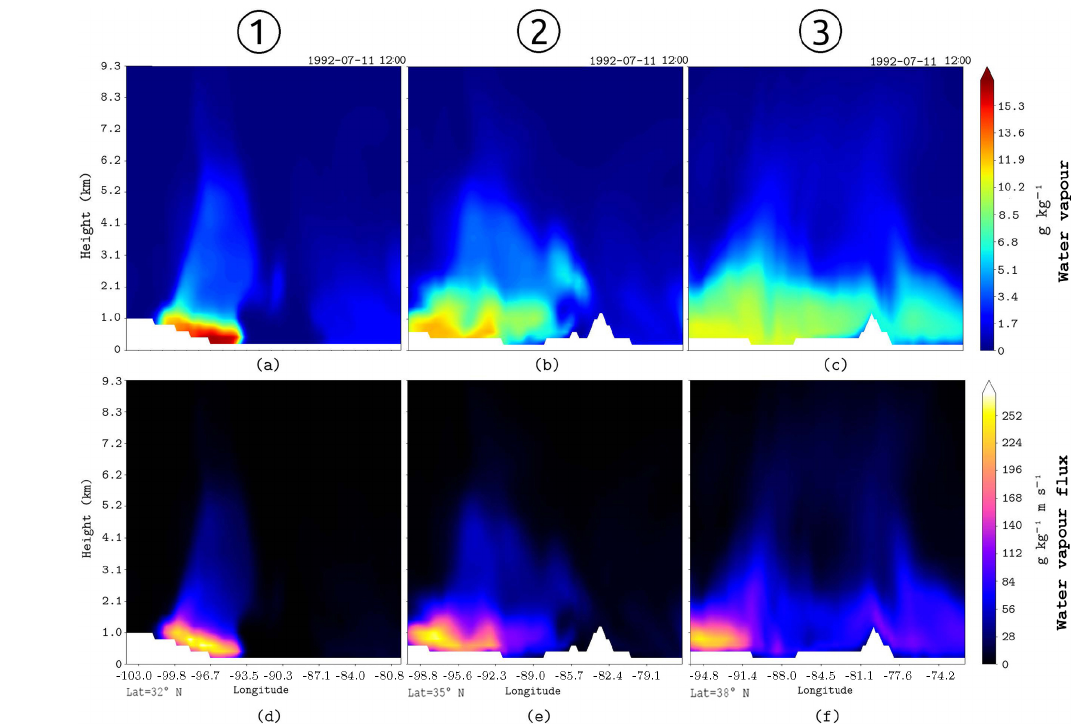
Figure 6. (a–c) q TR in gkg − 1 for the three vertical cross sections at the locations depicted by white lines in Fig. 5. Panels (d–f) same as (a–c) but for ϕ TR in gm (kgs) − 1 .